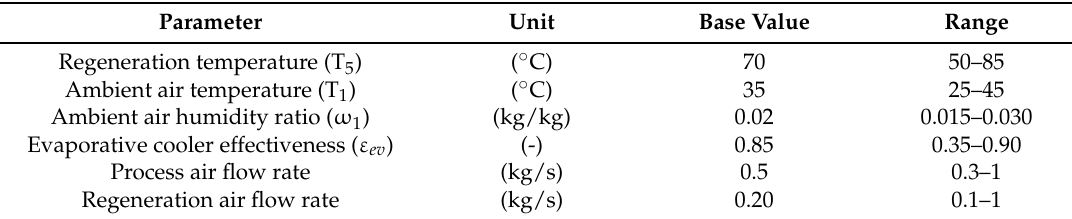
Table 3. The range and base value of different